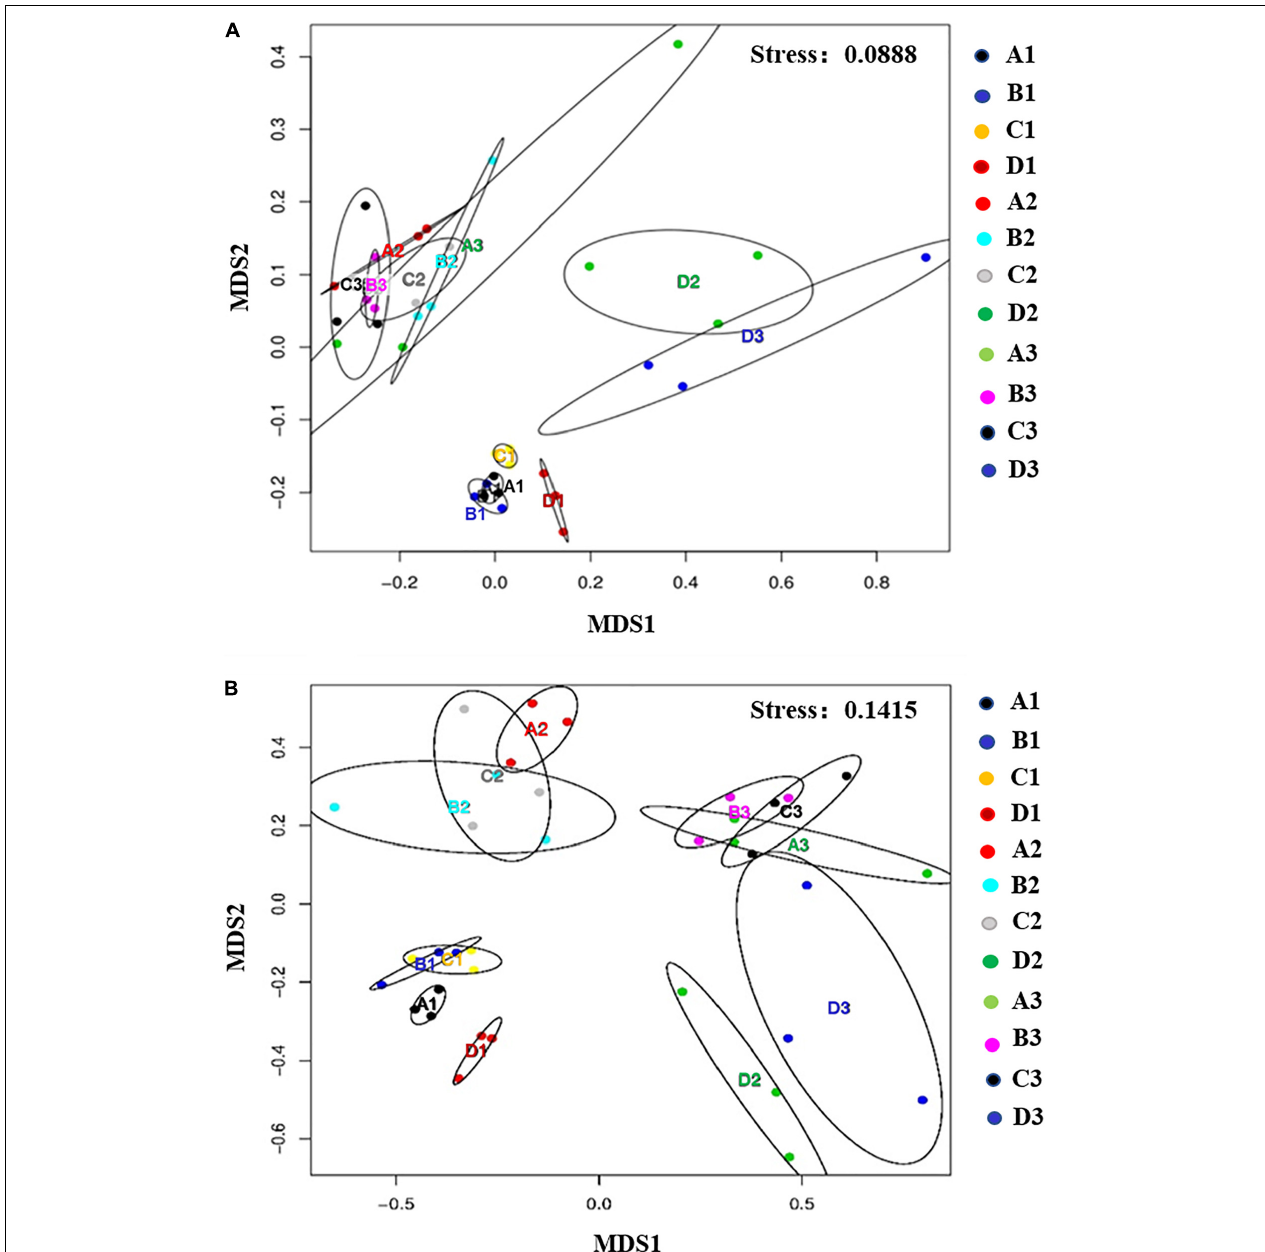
FIGURE 3 | Non-metric multidimensional scaling (NMDS) analysis showed the relationship between the samples in bacterial (A) and fungal (B) communities. First two dimensions of NMDS ordinations derived from the Bray–Curtis dissimilarity matrices were based on the relative abundance of bacterial and fungal families. A, non-treated; B, fenaminosulf; C, kasugamycin; D, dazomet. Numbers 1, 2, and 3 represent samples collected at 14, 55, and 110 days after soil treatment, respectively. The ellipse in each figure represents a confidence region, which was a multidimensional generalization of a confidence interval. The absence of intersection between ellipses indicates differences among treatments ( p <